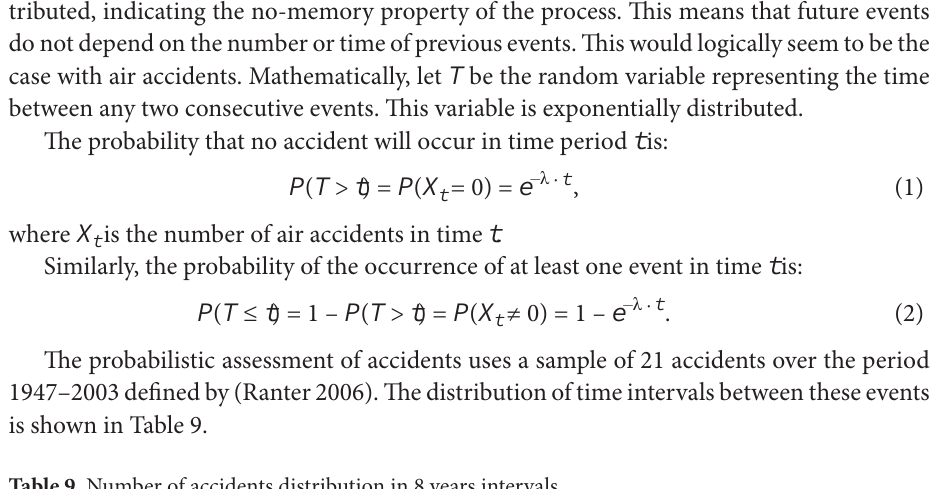
Table 9. Number of accidents distribution in 8 years intervals